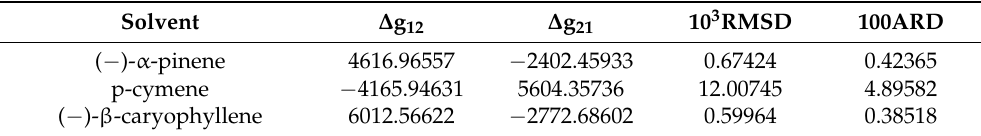
Table 6. Regression results and model parameters of the NRTL model of dehydroabietic acid in solvents.